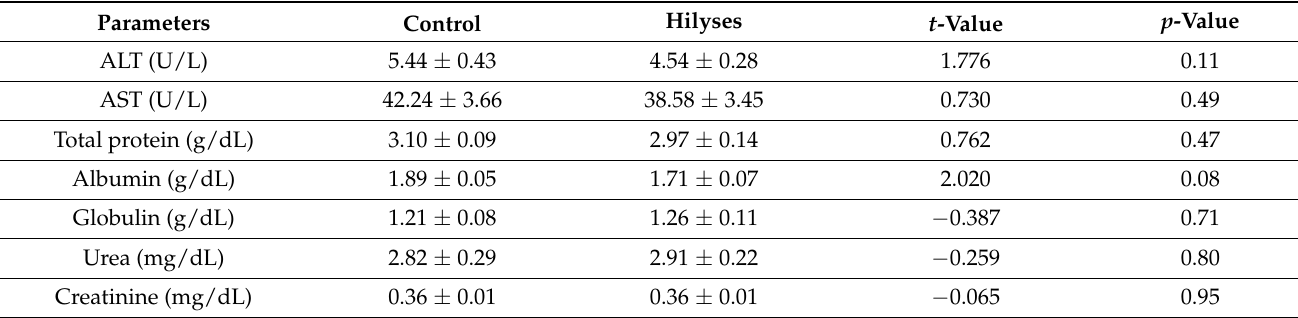
Table 5. Serum biochemical parameters of Nile tilapia broodstock-fed Hilyses and the control diets.